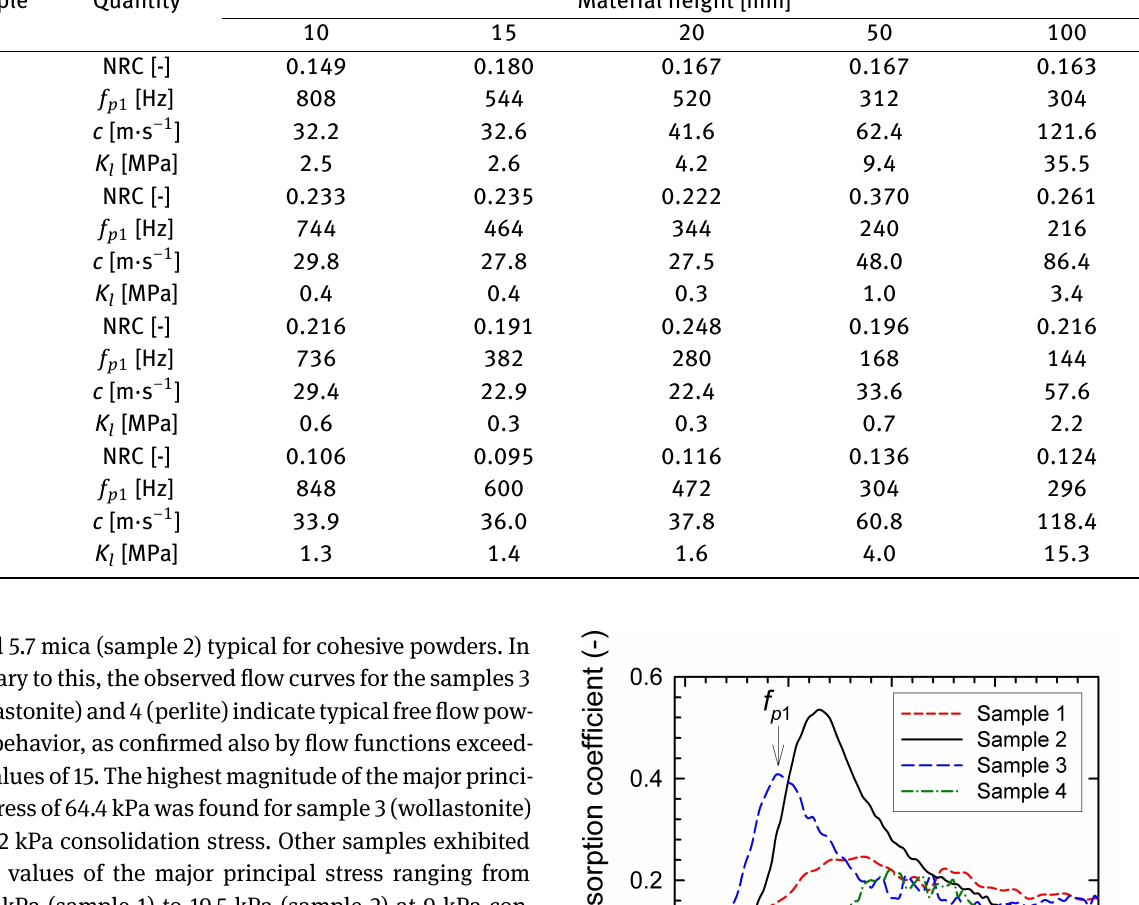
Table 3: Results of the acoustic and mechanical testing of the studied powder fillers Sample